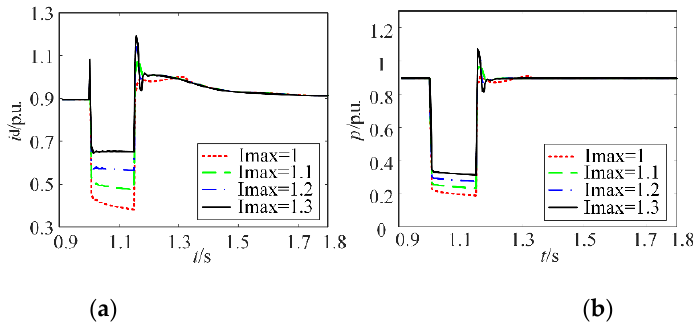
Energies 2021, 14, x FOR PEER REVIEW Figure 8. Simulation results in cases (1)–(4) of the fault on location A: ( a ) active current; ( b ) active output.